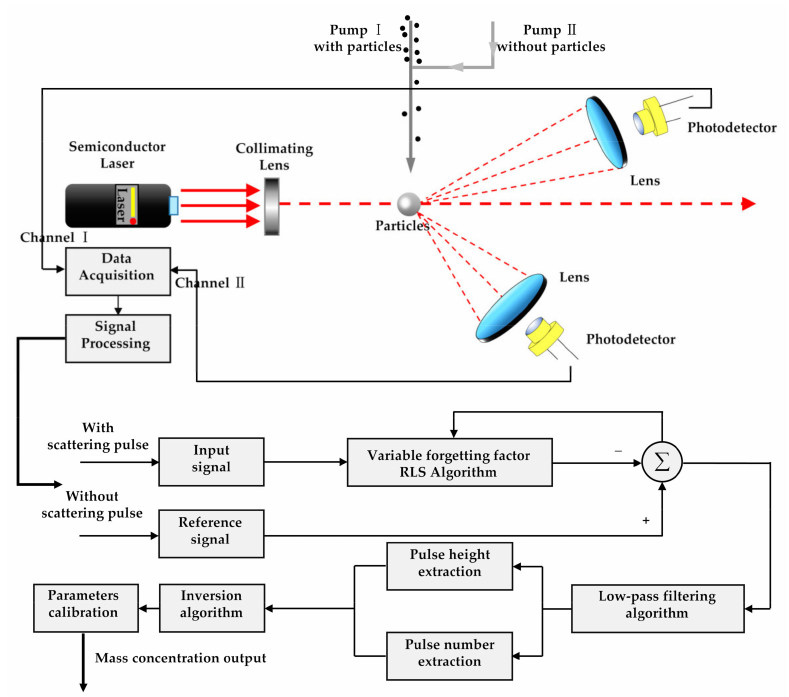
Figure 4. Flow chart of pulse signal